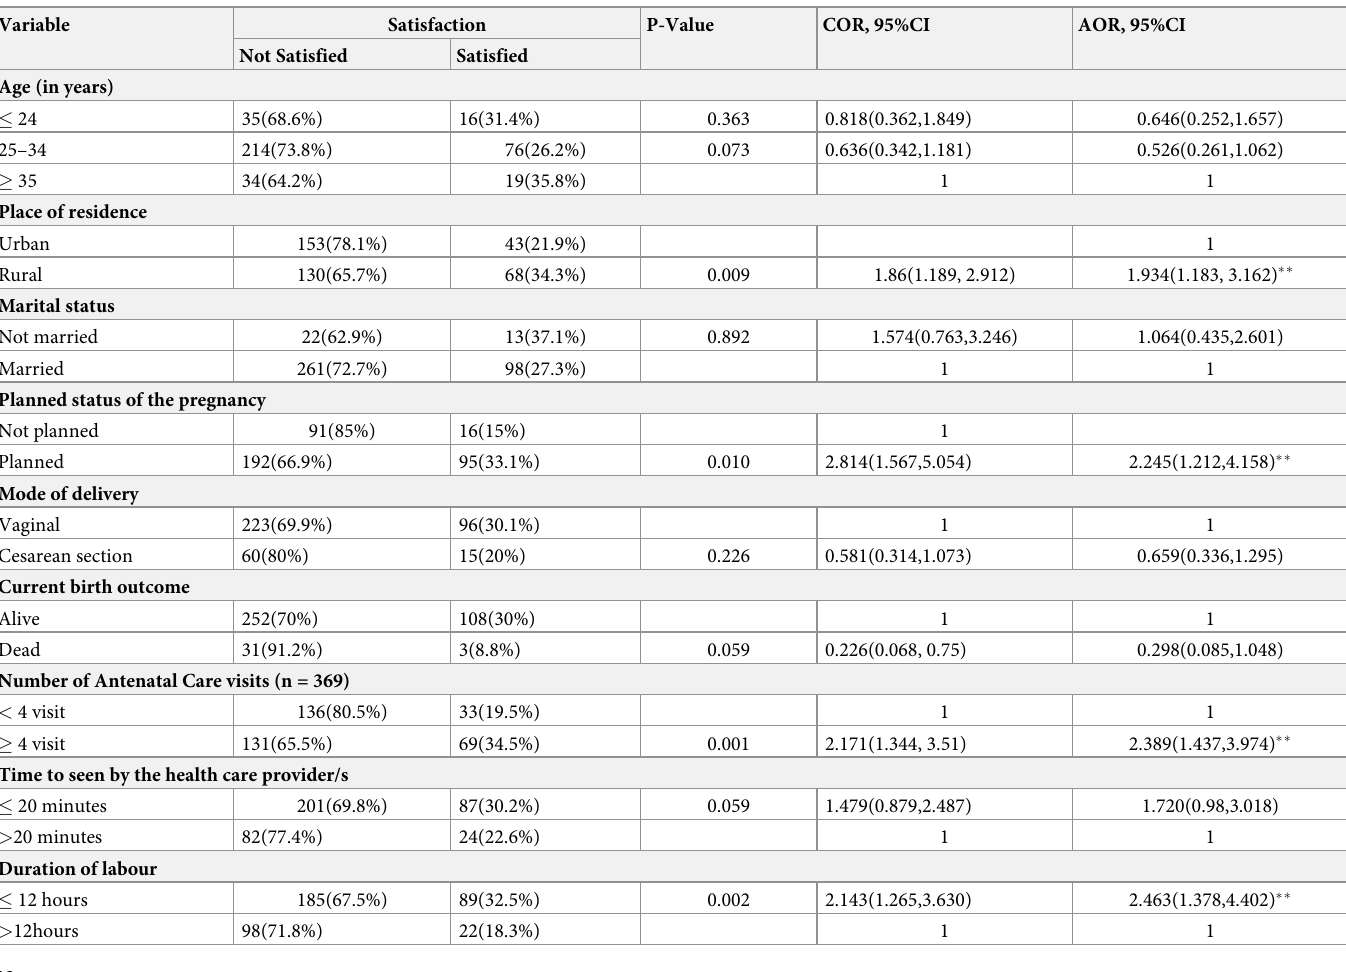
Table 3. Factors associated with maternal satisfaction with intrapartum care among postpartum women at public hospitals of North Shoa Zone Ethiopia (n =